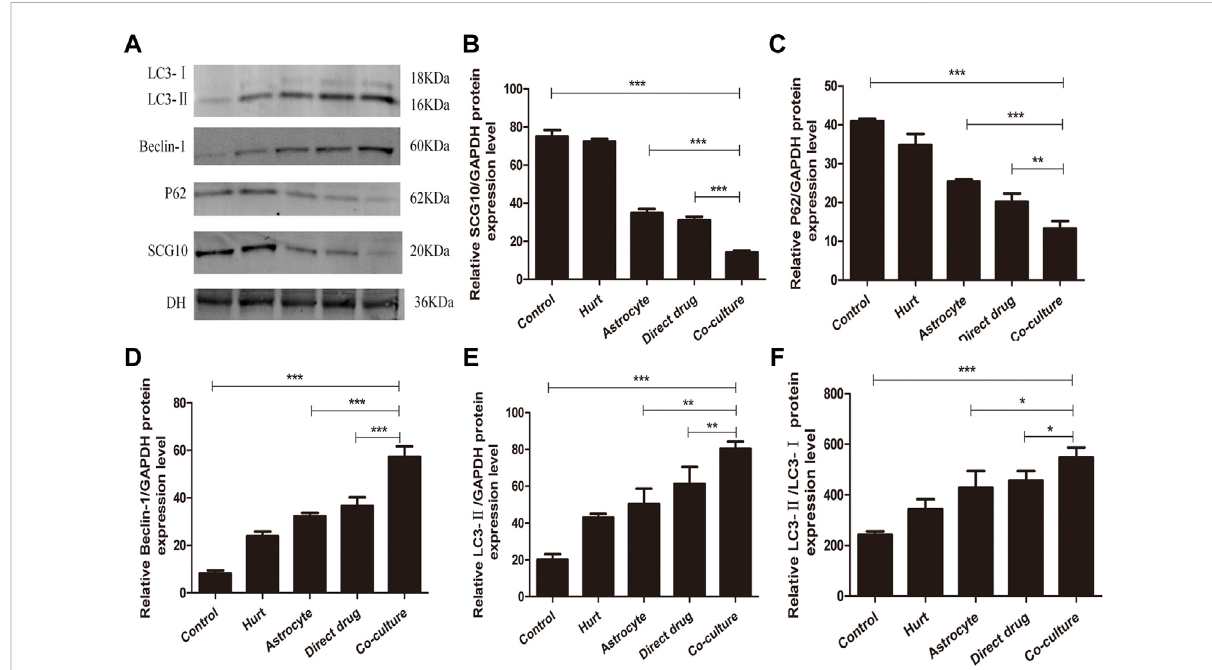
FIGURE 13 TFHLin fl uencesaxonsandautophagyrelatedproteinsexpressionininjuredSMNs. (A) Theexpressionofaxonandautophagy-relatedproteinin SMNs of each group was assessed by Western blot assay. (B – F) The comparison of relative densitometry values between each group. All data are expressed as the mean ± SD. Differences among groups were determined with one-way ANOVA followed by a least-signi fi cant difference post